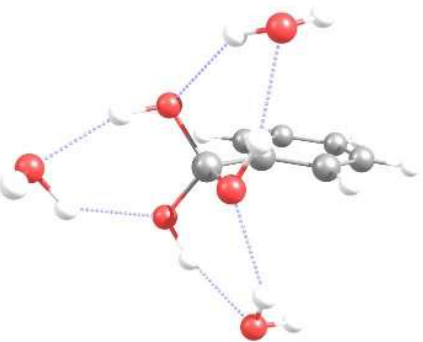
Figure 7. Optimized geometry corresponding to three water molecules interacting with the -C(OH) 3 functionalized benzene, calculated at RIMP2/def2-TZVPP-level of theory. Dashed lines indicate the hydrogen bonds formed between water and the functional group.